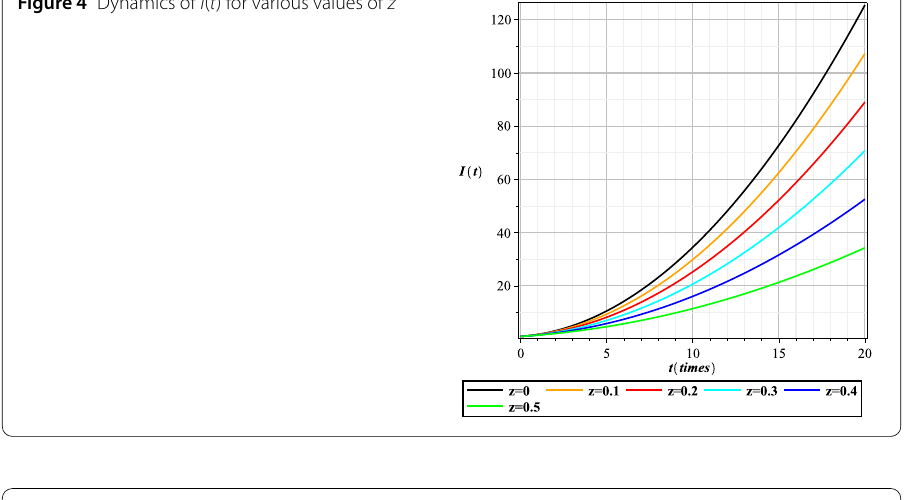
Figure 5 Dynamics of I ( t ) for various values of